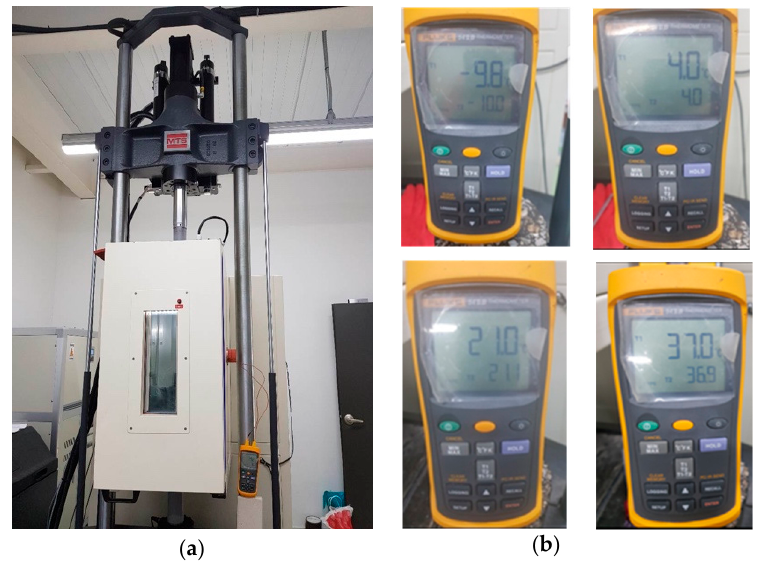
Figure 2. Equipment: ( a ) MTS system with temperature chamber; ( b ) thermometer.